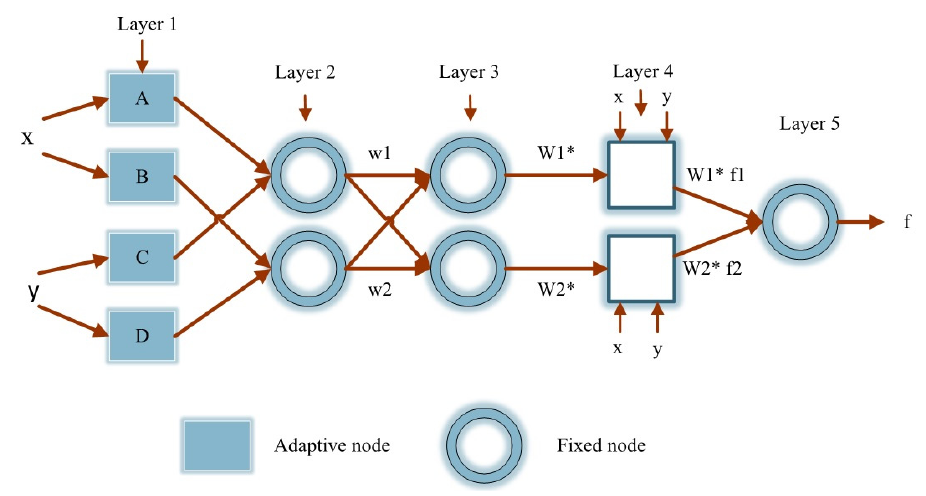
Figure 12. ANFIS layers [49] .